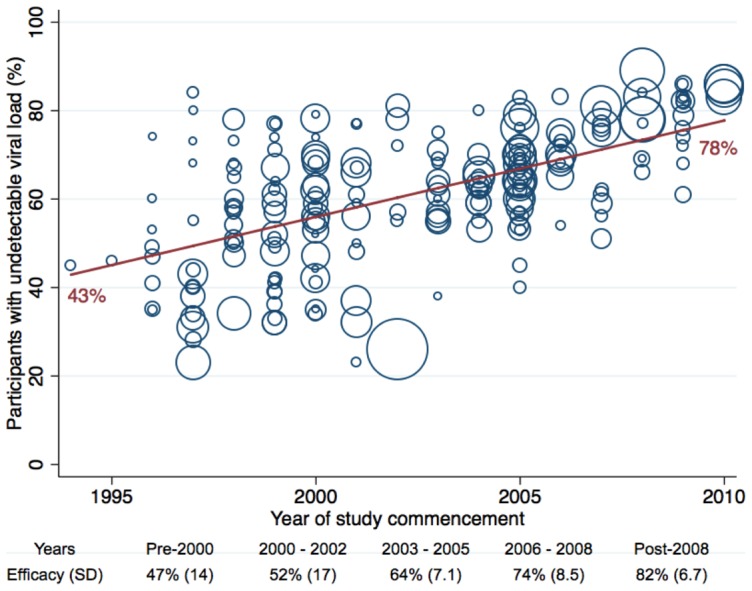
Efficacy by year of study commencement.Summary bubble plot displaying the change in weighted intention-to-treat antiviral efficacy of initial antiretroviral therapy by the year included studies were commenced. Each bubble represents an individual treatment group, proportional to size. SD, standard deviation.